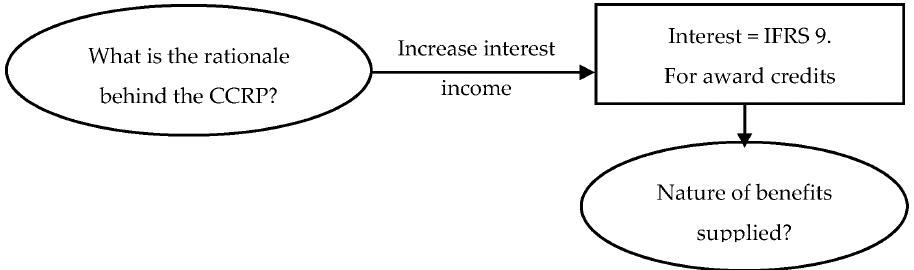
Figure 4. Rationale behind the CCRP is an increase in interest.